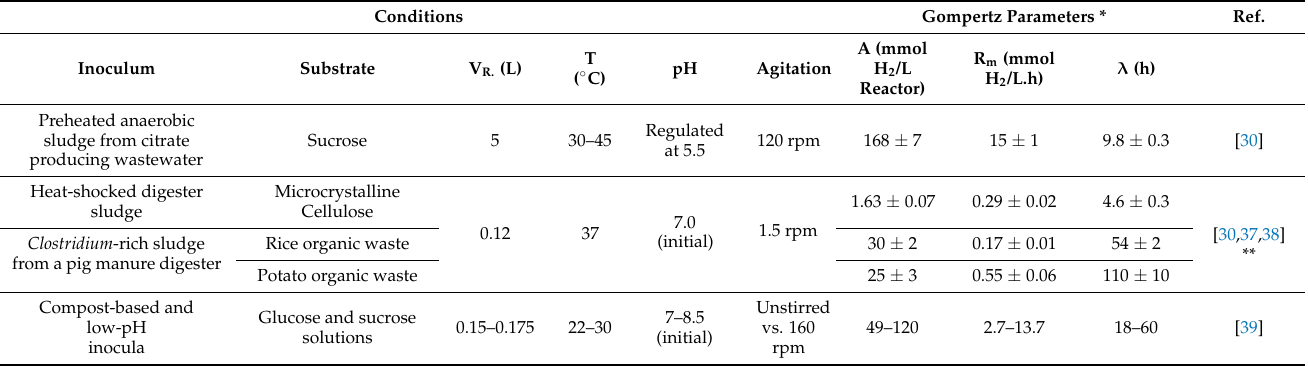
Table 4. Summary of Gompertz model parameters estimated from different works aimed at obtaining hydrogen from effluents and solid wastes.